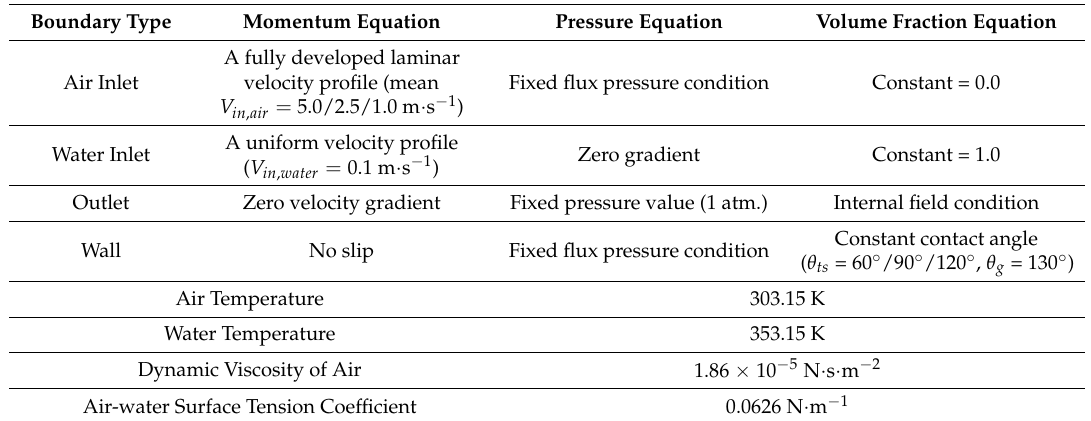
Table 2. Boundary conditions and material